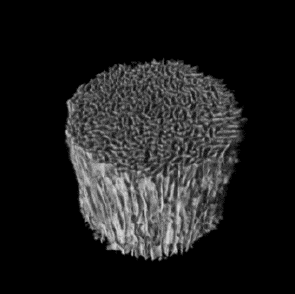
Figure 1. Pore architecture of UDPHAp. The pores are unidirectionally orientated parallel to the long axis of the